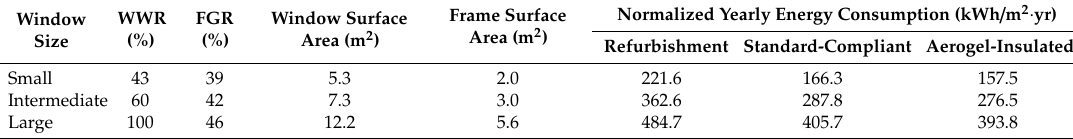
Table 3. Yearly energy consumption normalized to frame surface